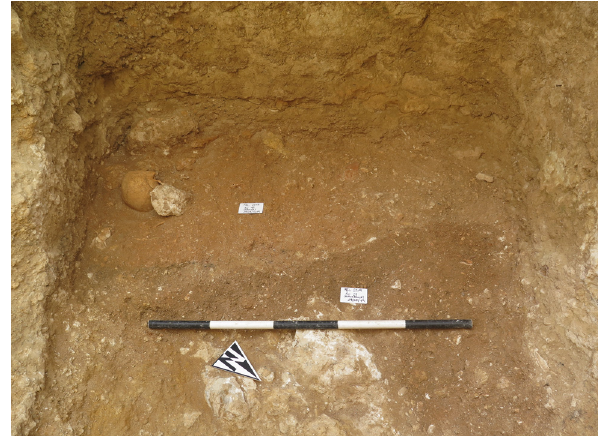
Figure 5: Skeleton 5 in early phase